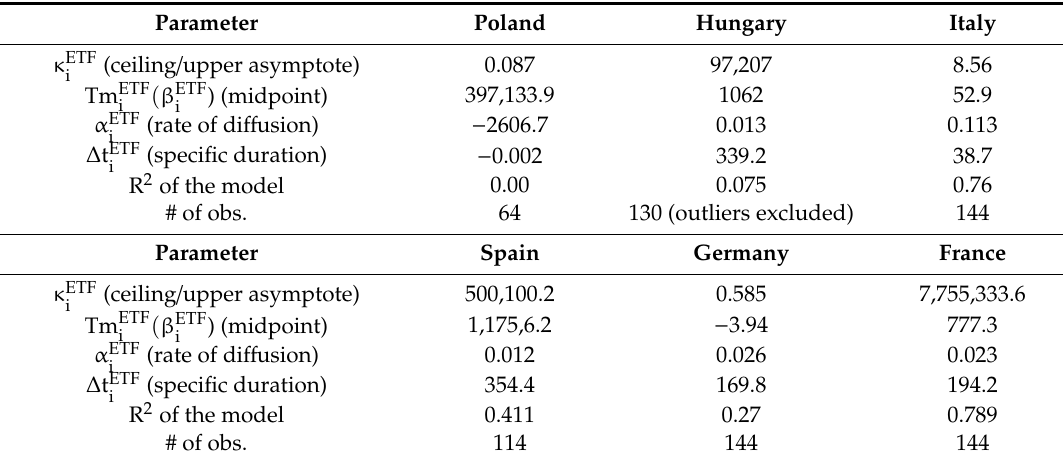
Table 3. Di ff usion of exchange traded funds (as share of total turnover of index financial instruments). Logistic growth model estimates. 2004–2015 (monthly time series). Poland—data from 2010m9; Hungary—data from 2005m1; Spain—data from